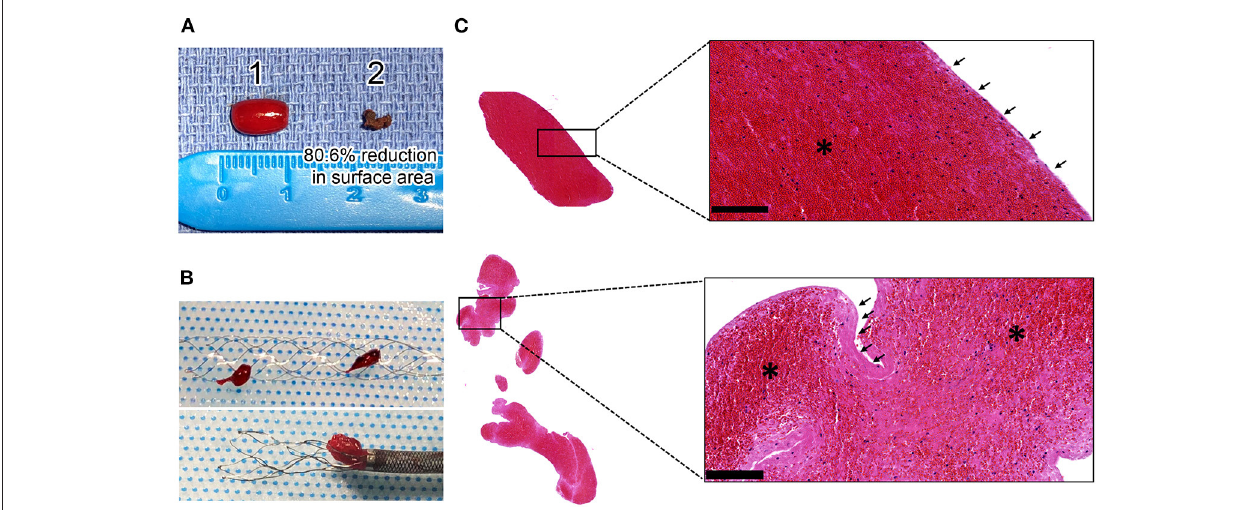
FIGURE 3 | Histological aspect and organization of human thrombi causing large vessel occlusion (LVO) in the simulation station. (A) Representative image of a human RBC-rich clot before in flow injection (1) and after (2) its retrieval by EVT. (B) Macroscopic view in the stent retriever of the RBC-rich thrombus fragmented into two pieces (top panel) and a platelet-rich thrombus stuck in the aspiration catheter (panel at the bottom) (C) Representative H and E staining images of an RBC-rich (top) and platelet-rich (bottom) thrombus at the bottom showing: RBC-rich areas in red (*), fibrin/platelet-rich area in pink (arrows) and leukocytes in purple. Insets show higher magnification views of the squared areas. Bars = 100 µ